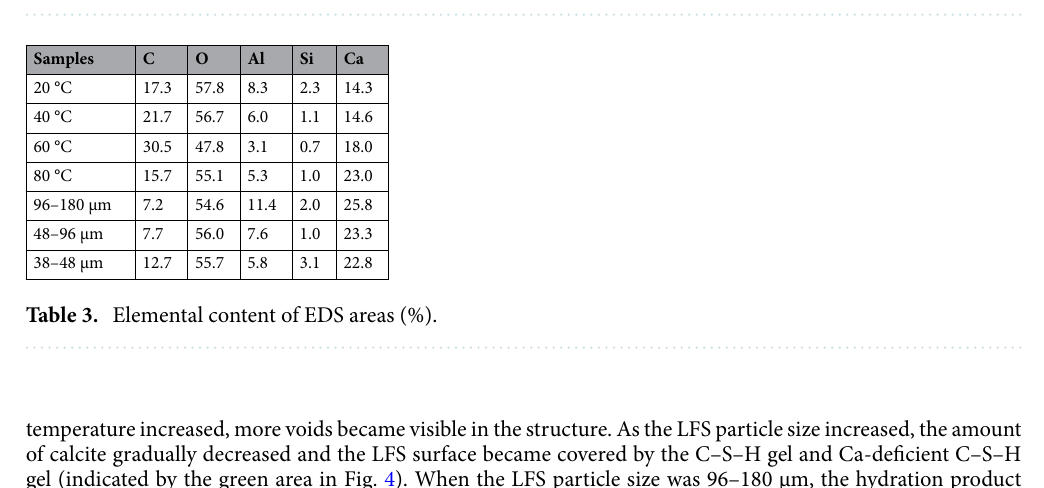
Figure 5. Schematic diagram of the microstructure mechanism of hydration and carbonation of LFS.